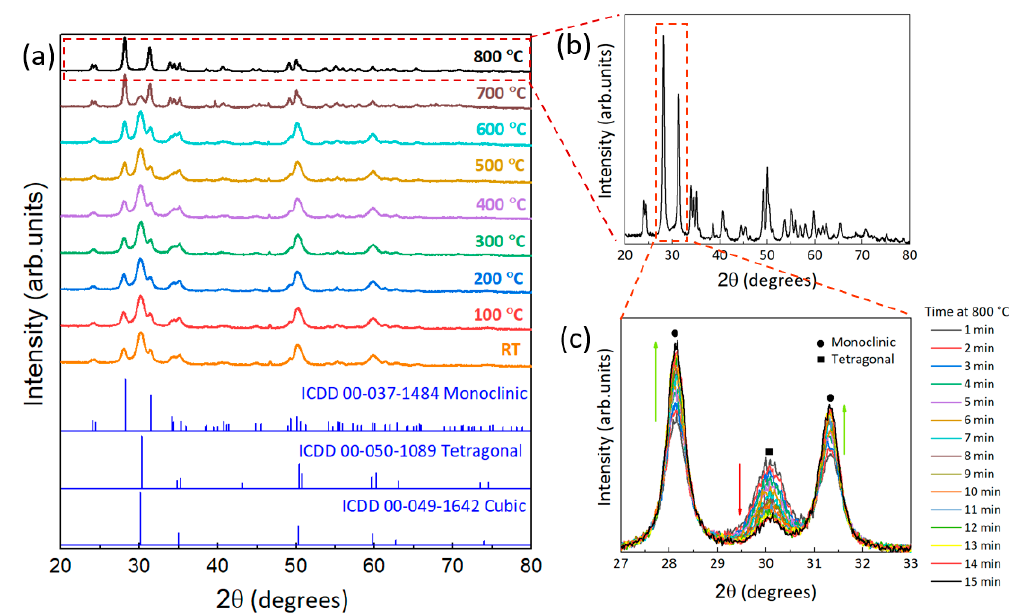
Figure 3. ( a ) In situ XRD diffractograms of the ZrO 2 nanopowder synthesized under microwave irradiation with different annealing temperatures ranging from RT to 800 °C with a plateau time of 15 min. For comparison, the simulated monoclinic, tetragonal and cubic zirconia structures are also presented. ( b ) XRD diffractogram of ZrO 2 nanopowder synthesized under microwave irradiation